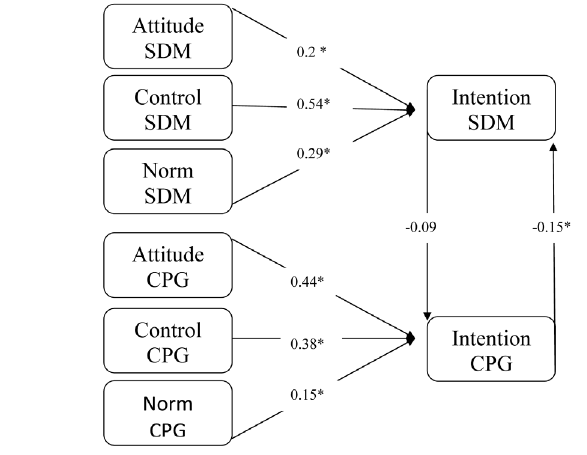
Figure 4. Standardized path analysis coefficients for experi- mental group at study exit, showing attitude, perceived behavioral control and subjective norm as predictors of physicians’ behavioral intentions to engage in SDM and to follow CPGs; and showing the influence of the intention to engage in SDM on the intention to follow CPGs and vice versa (vertical arrows).